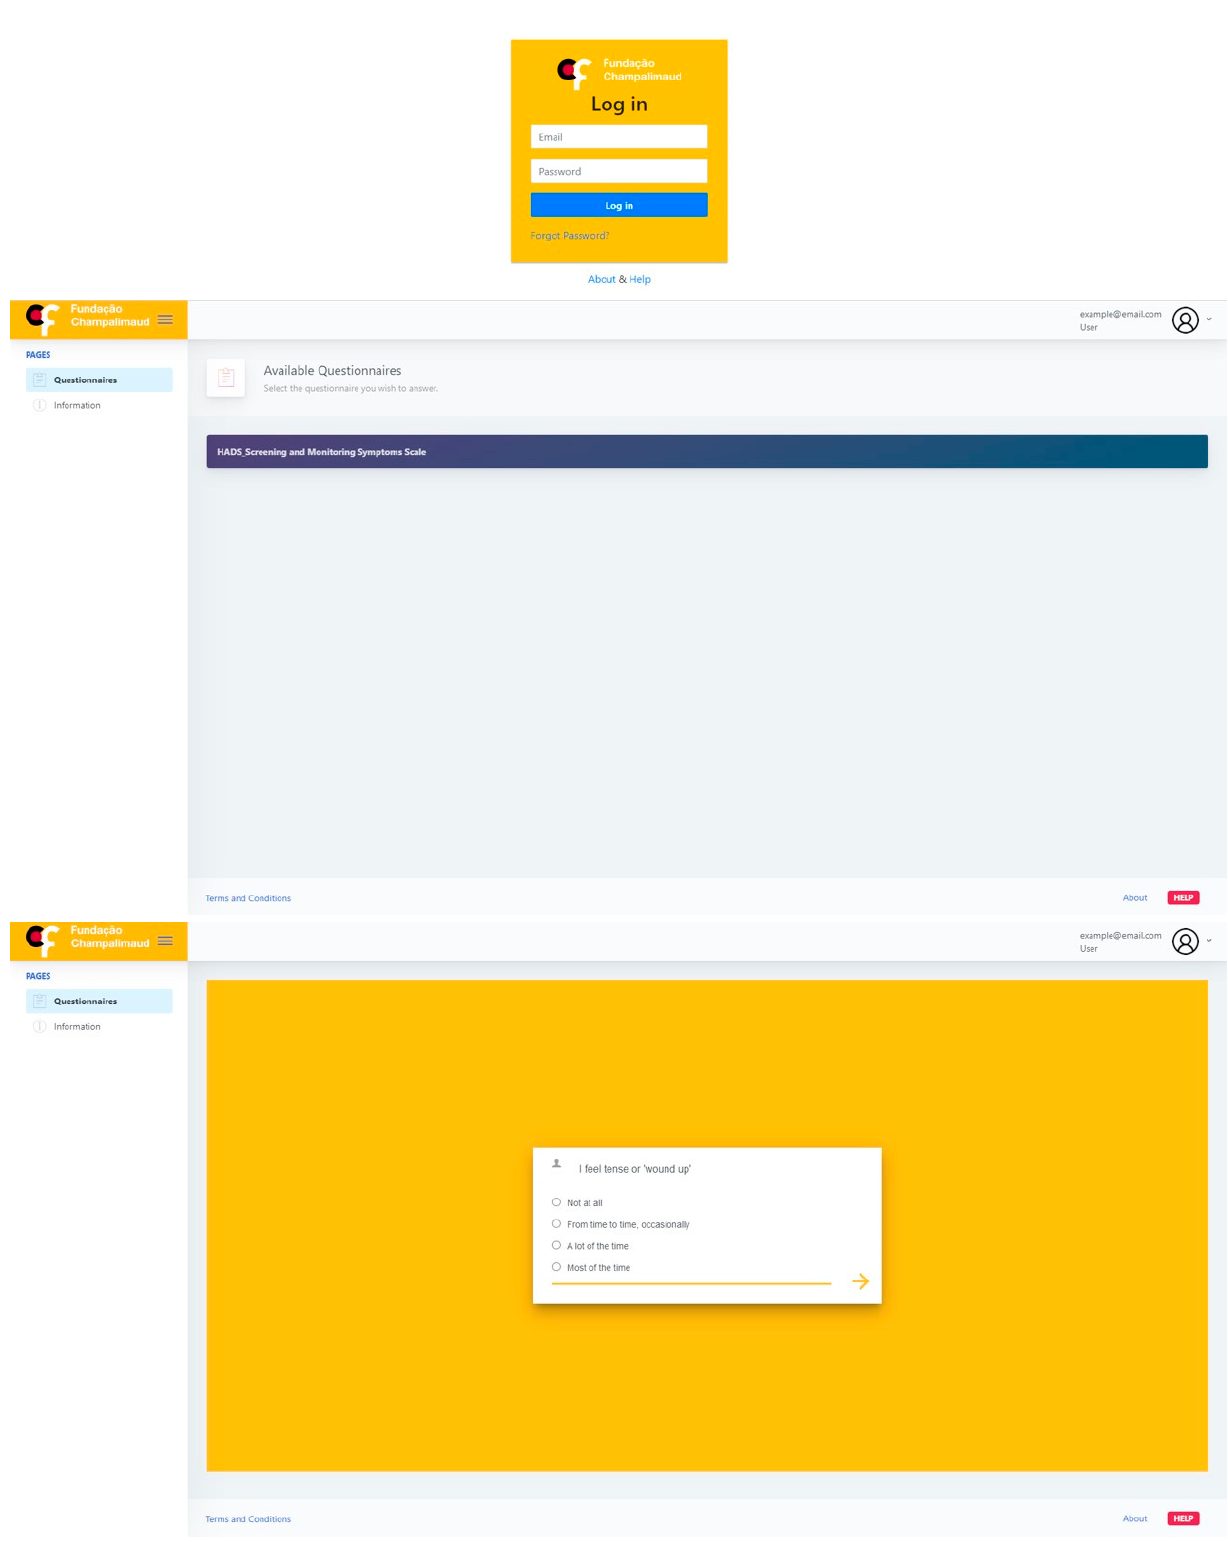
Figure 1. MoodUP platform